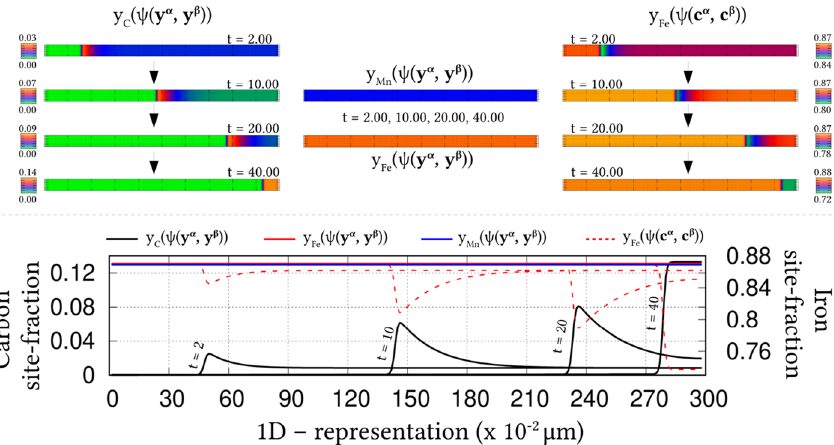
Figure 12. (Top) Respective time-dependent and -independent concentration distribution of carbon, manganese and matrix-species accompanying growth of ferrite under paraequilibrium. Evolution of Fe-concentration distribution, which inaccurately captured by the convention mole-fraction based technique, is included. (Bottom) One-dimensional concentration profiles depicting the evolution of carbon, and time- invariant behaviour of Fe- and Mn-concentrations. Reverse complementing diffusion of Fe-matrix, inherently alluded by the conventional approach ( ψ( c α (µ) , c β (µ)) ), is illustrated by the change in the Fe-concentration